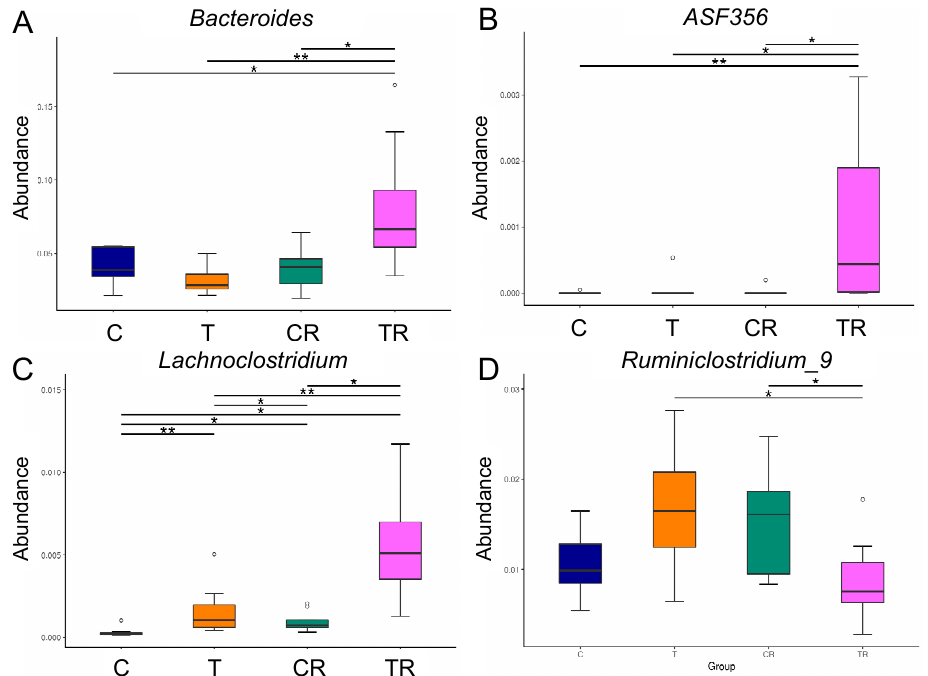
Figure 3. Effect of 2,3,7,8-tetrachlorodibenzo-p-dioxin (T) and resveratrol (R) on the gut microbiome in 12-week-old offspring. Relative abundance of the genera ( A ) Bacteroides , ( B ) ASF356 , ( C ) Lachnoclostridium , and ( D ) Ruminiclostridium_9 . C = control rats received vehicle; T = rats received weekly oral dose of TCDD 200 ng/kg for four doses; CR = control rats received 50 mg/L of resveratrol in drinking water during pregnancy and lactation; TR = rats received TCDD and resveratrol treatment. * p < 0.05; ** p < 0.01.